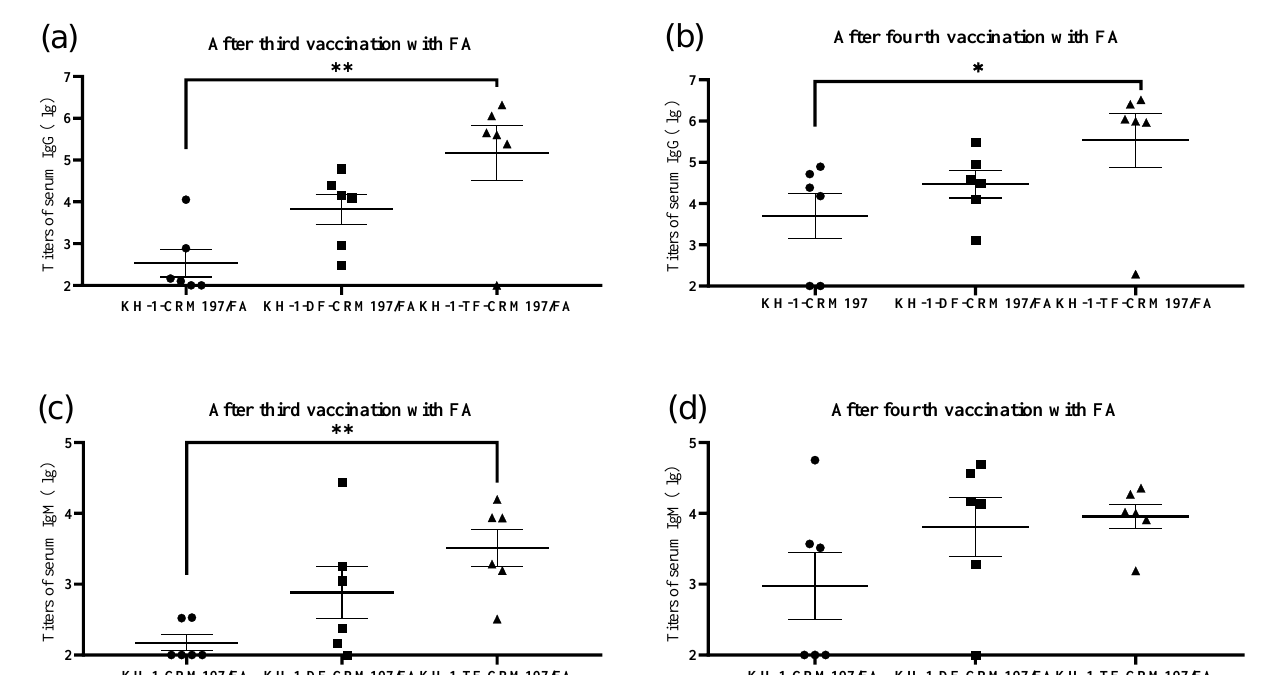
not be detected when diluted 1:100.